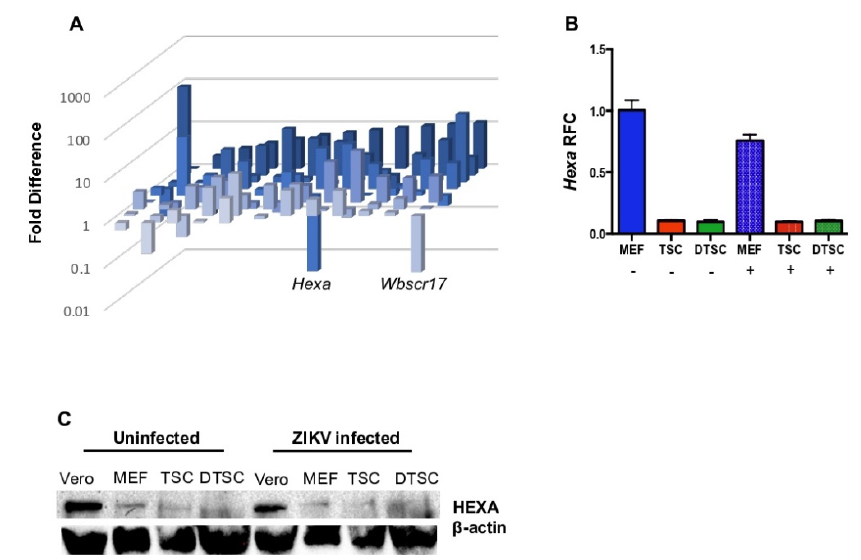
Figure 5. The expression of the glycosylation-related gene and Hexa was decreased in TSCs and DTSCs. ( A ) qPCR array analysis of mouse glycosylation-related genes in MEFs and TSCs. ( B ) MEFs, TSCs, and DTSCs were infected with ZIKV (1 MOI) for 24 h, and the expression of Hexa was measured and related to the uninfected MEFs and normalized with cellular β‐ actin . ( C ) The reduced level of HEXA in TSCs and DTSCs was further confirmed at the protein level. The levels of HEXA and β‐ Actin in ZIKV ‐ infected and uninfected Vero, MEFs, TSCs, and DTSCs were quantified by immunob ‐ lotting assay. The results were analyzed by using a two ‐ tailed Student’s t ‐ test ( B ). The results are representative of at least two independent experiments and are expressed as mean ± SEM ( B ).